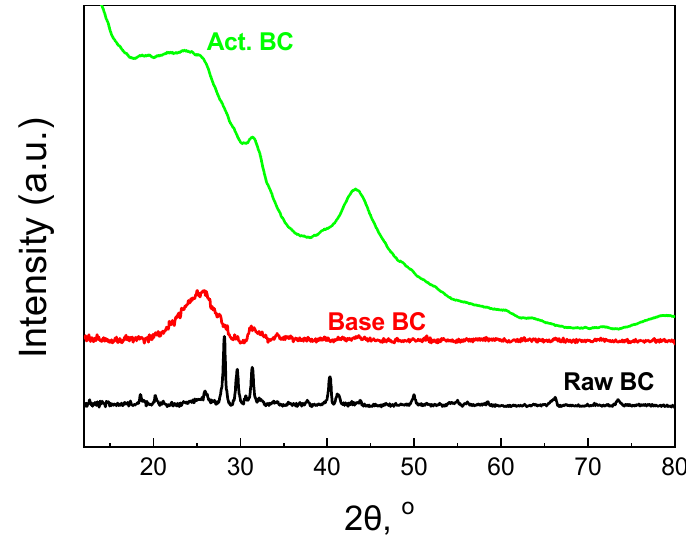
Figure 5. XRD patterns of the studied biochars.